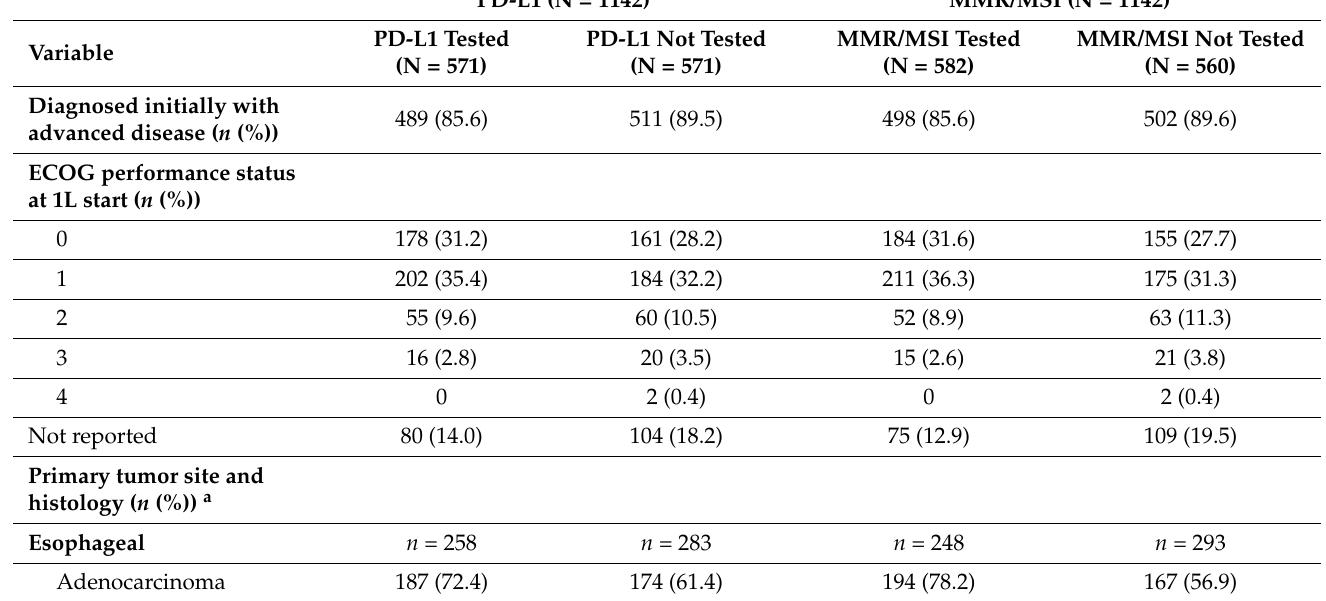
Table 1. Baseline clinical and disease-related characteristics by PD-L1 and MMR/MSI testing status. PD-L1 (N =